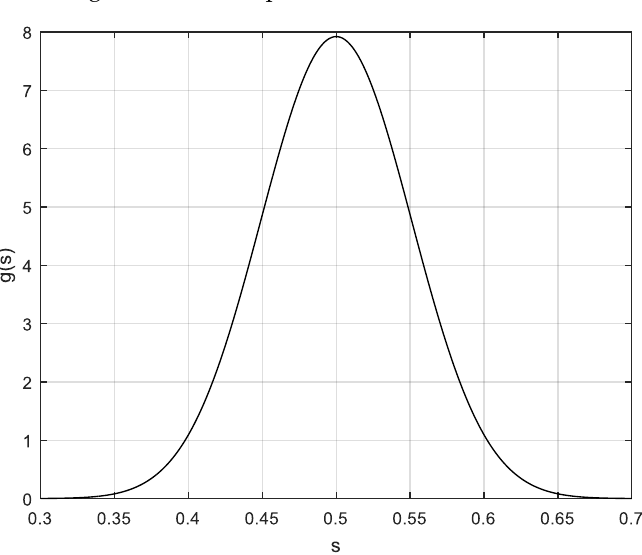
Figure 6. Beta prior PDF of S of case B1, with mean 0.5 and CV = 0.15 (as in Equation (43), with parameter values: p = q = 21.722).